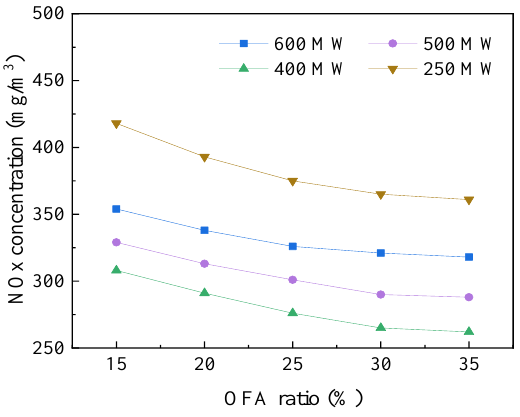
Figure 12. Variation in NOx concentration at economizer outlet with the OFA ratio.